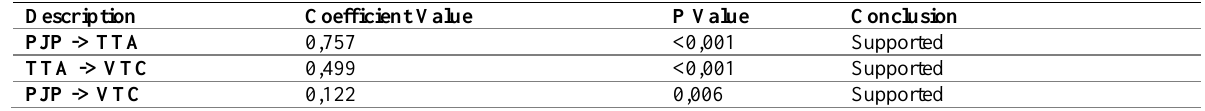
Table 4: Hypothesis Test Result